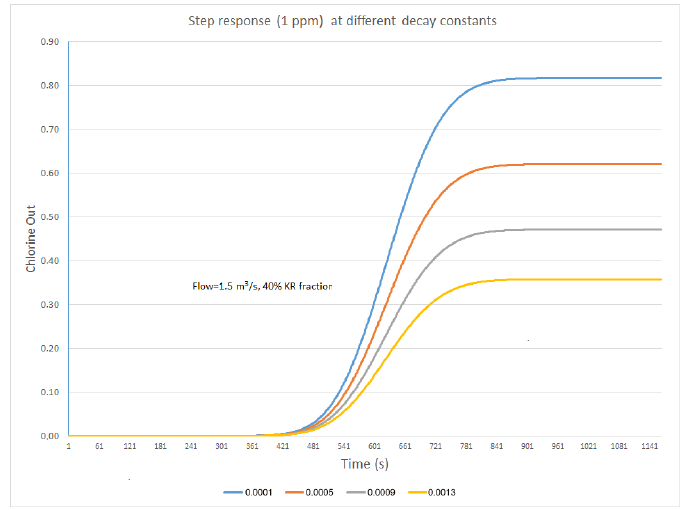
Figure 6. Step response for a dose of 1 ppm of chlorine for different values of k R (0.0001, 0.0005, 0.0009, 0.0013 s − 1 ).